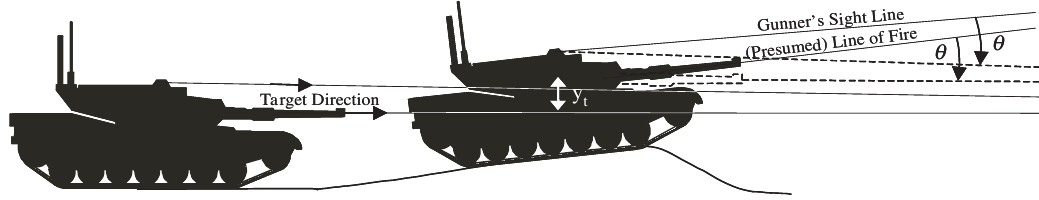
Fig. 1. Caricature of rigid-body motion of the sight and barrel while target tracking as the tank traverses a bump.